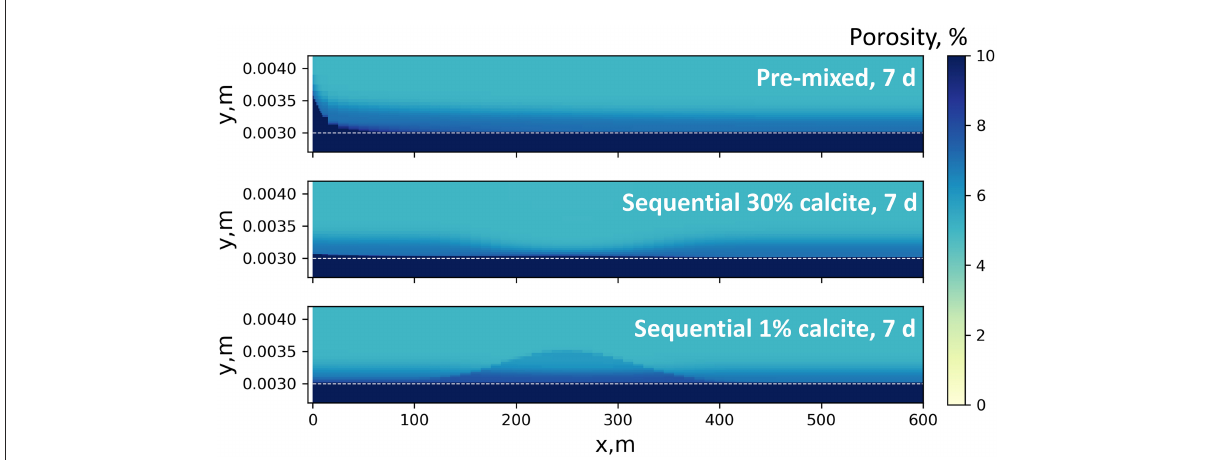
FIGURE8 Porosity maps of the pre-mixed and sequential 2D models after 7 days of overall reaction time. Note that the y-axis range is much narrower than that in the pH maps. The white dotted line denotes the location of the fracture surface. Porosity increase (fracture opening, dark blue zones) is mostly observable in the pre-mixed model close to the injection point. In the sequential model with 30% calcite, porosity increase occurs along the fracture path. Minor porosity increase is observed in shale matrices in all cases due to diffusion of acid into the shale matrix. Porosity map of the sequential system with a lower calcite content shows a distinct pattern of porosity alteration: porosity increase is most observable close to where the concentrated HCl stops at the beginning of the no-flow shut-in stage. This demonstrated the dependence of spatial distribution of mineral reactions on mineralogy